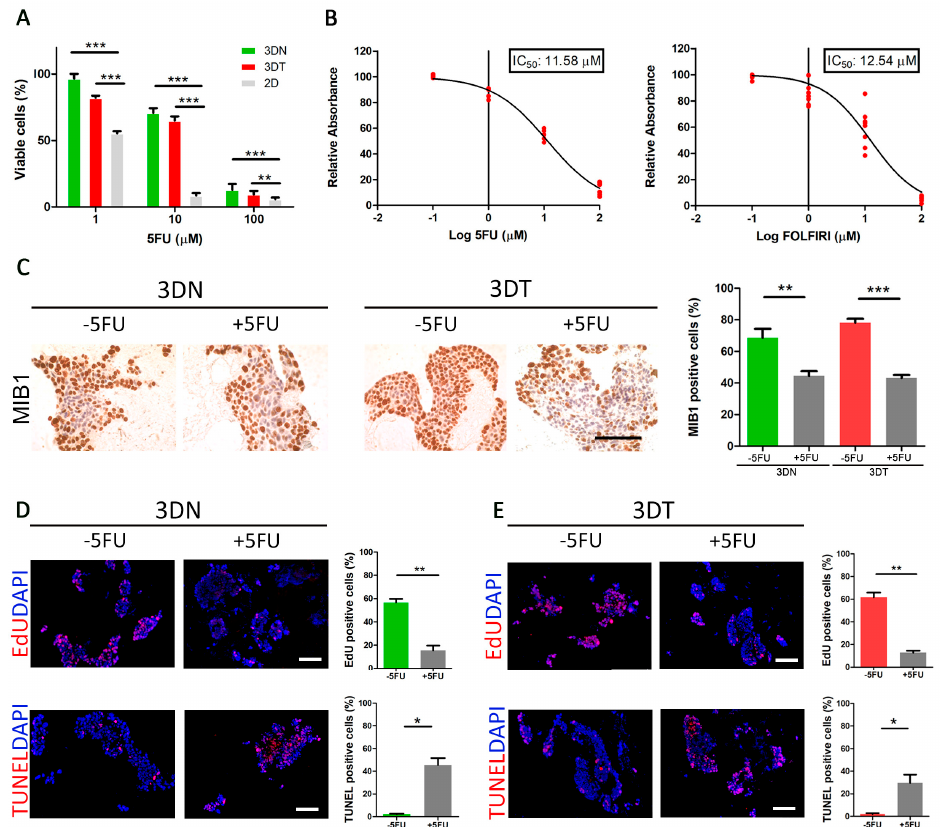
Figure 2. Effect of 5-fluorouracil (5FU) and FOLFIRI ((leucovorin + 5-fluorouracil (5FU) + irinotecan) treatments on HT29-cells cultured in a 3D model. ( A ) Comparison between percentages of viable cells (by absorbance fold-change detection) after administration of 5FU at 1-10-100 µM in 2D cultures and in both 3DN and 3DT models. ( B ) Calculation of 5FU and FOLFIRI 3D IC 50 by nonlinear regression. ( C ) MIB1 immunohistochemistry before and after administration of 3D-calculated IC 50 in both 3DN and 3DT; comparison of percentages of MIB1 + cells before and after treatment (scale bar = 100 µm). ( D ) EdU staining as a marker of proliferation and TUNEL staining as a marker of apoptosis, before and after 5FU treatment in 3DN and relative quantification (scale bar = 100 µm). ( E ) EdU and TUNEL before and after 5FU treatment in 3DT and relative quantification (scale bar = 100 µm) (* p -value < 0.05; ** p -value < 0.01; *** p -value < 0.001).